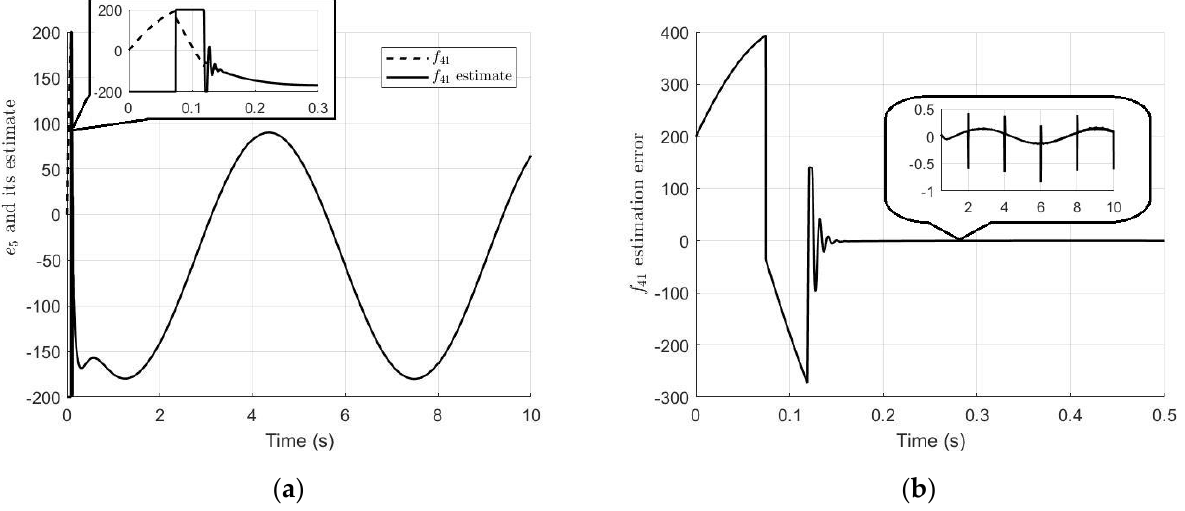
tfte = and its estimate 415